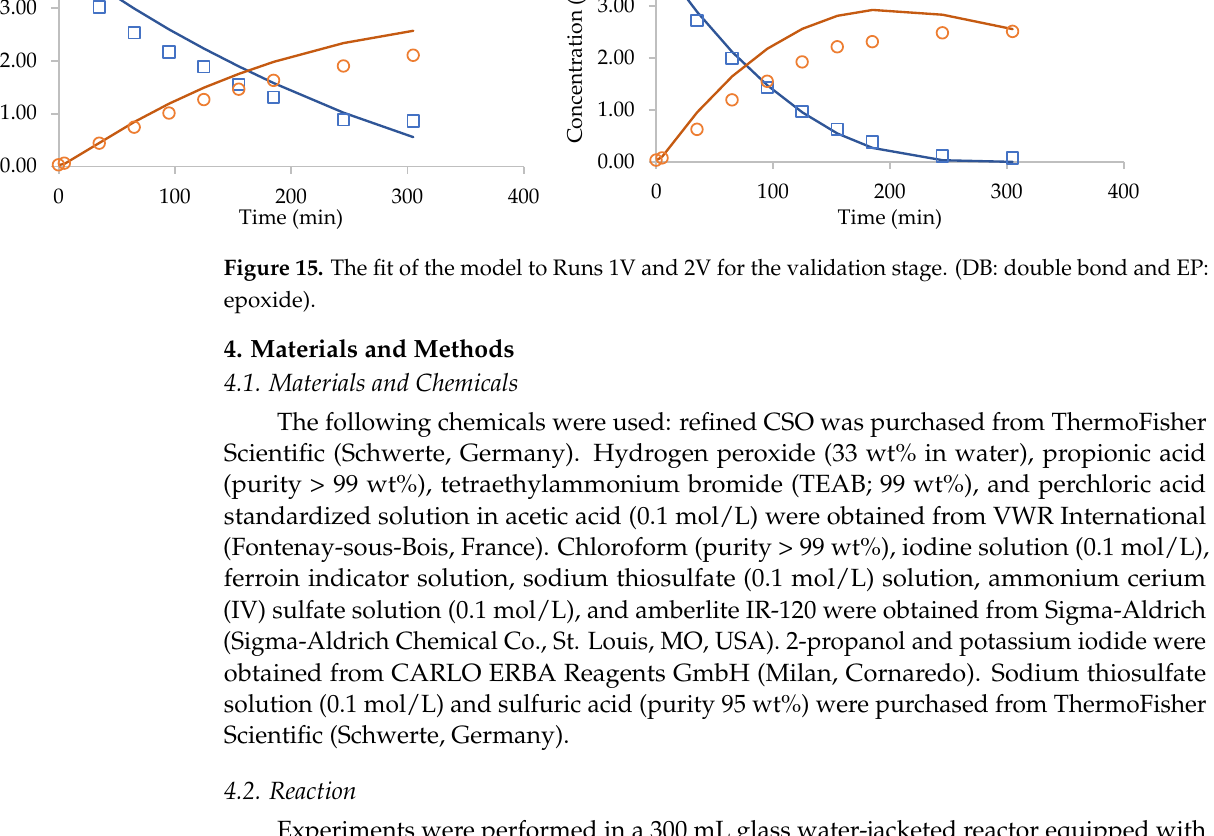
Scientific (Schwerte,